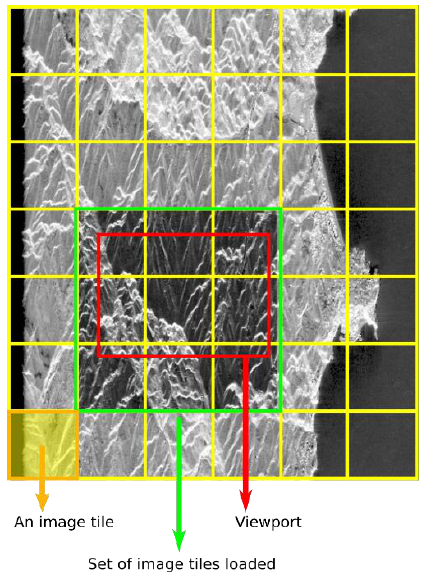
Figure 10: Background image tiles and